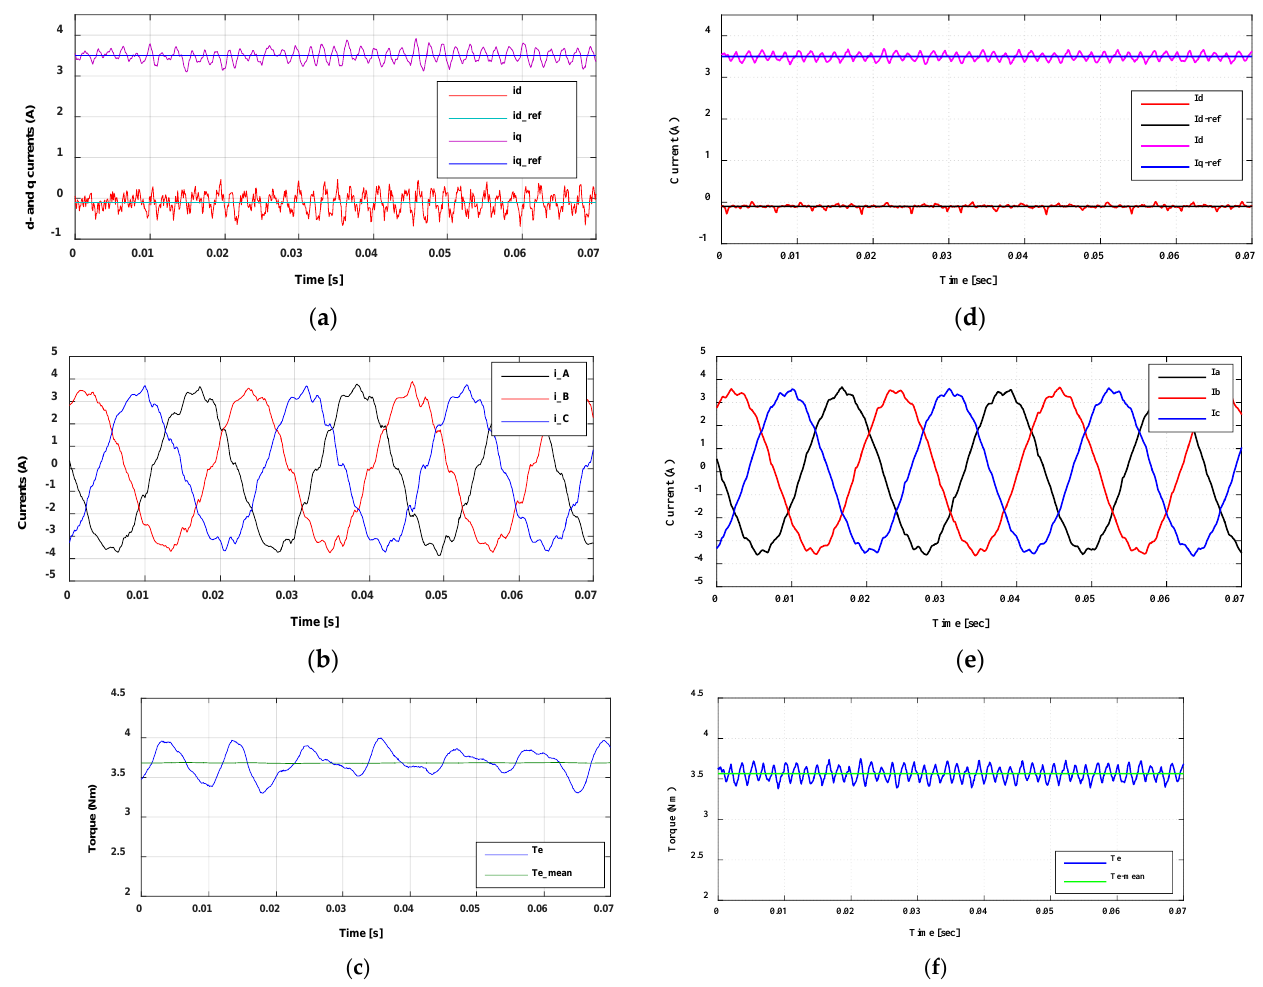
Figure 17. Comparison between measurement and simulation results as a motor: ( a ) the measured direct and quadrature currents; ( b ) the measured waveform of phases’ currents; ( c ) the measured electromagnetic torque; ( d ) the simulated direct and quadrature currents; ( e ) the simulated waveform of phases’ currents; ( f ) the simulated electromagnetic torque.